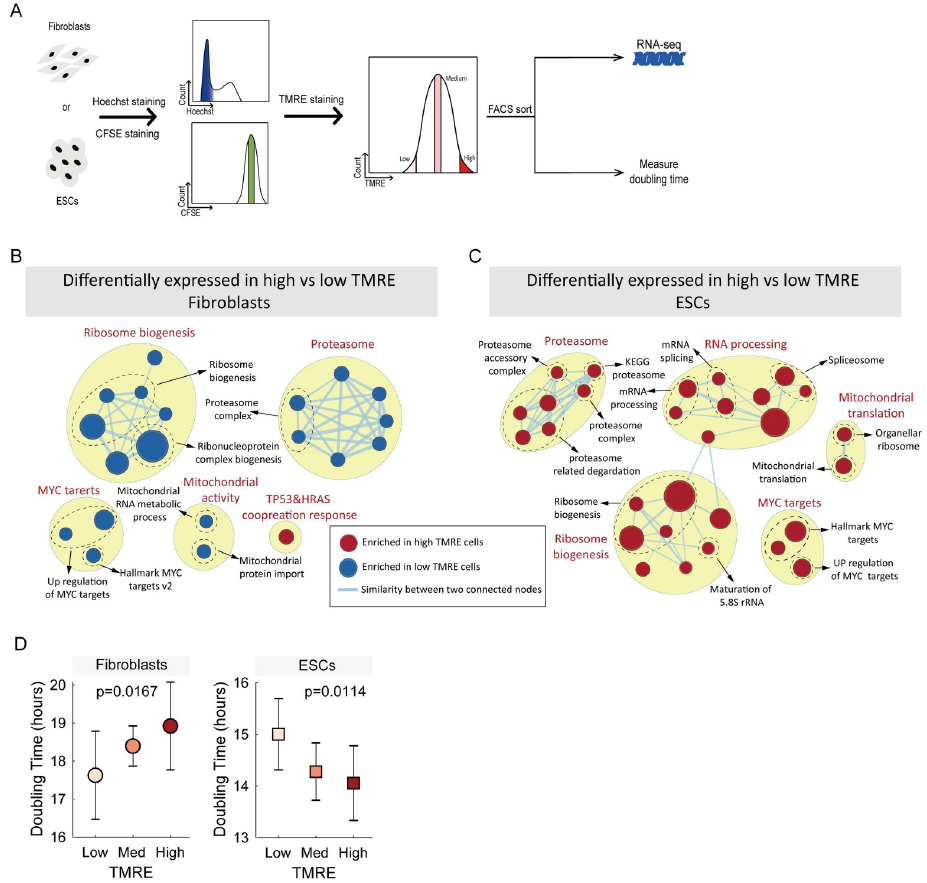
Fig 6. Expression of proliferation-related gene sets in cells sorted by intra-population heterogeneity in mitochondria membrane potential. (A) Cells were stained with Hoechst and CFSE and a homogenous population of equally sized cells in G1 with equal CFSE was obtained by FACS. These cells were stained with TMRE sorted by TMRE, and then used for RNA-seq, or allowed to proliferate to measure the doubling time of each TMRE sub- population. (B, C) Enrichment maps of fibroblasts and ESCs sorted by TMRE. (D) Doublings times, as estimated by the measured by the decrease in CFSE signal over time, for high, medium and low TMRE sorted cells. P-values are from ANOVA, testing if TMRE is predictive of doubling time (see Materials and